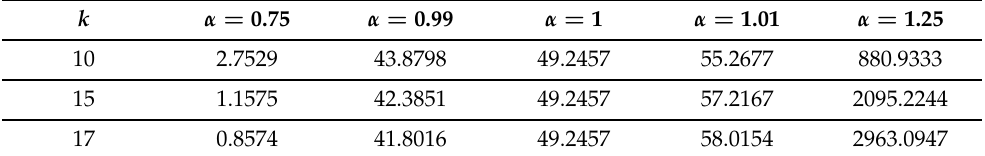
Table 1. Estimations of the C constant in the condition for Hölder continuity with exponent α for approximations of the limit function with k levels of subdivision for initial data coming from 30 point values of the function f ( x ) at the grid X 1 of non-equally spaced abscissas.